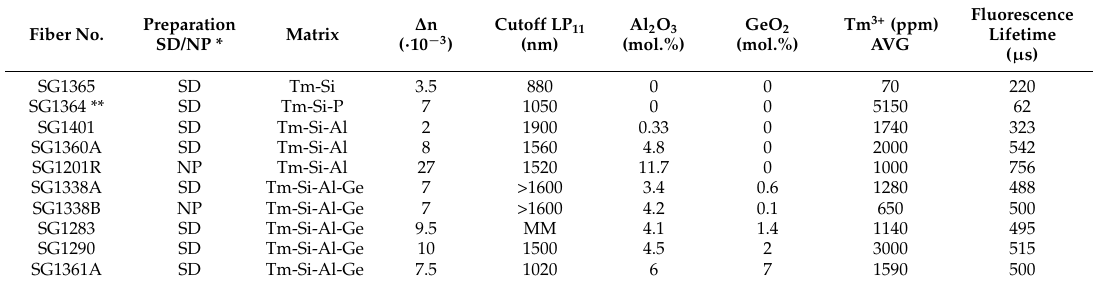
Table 1. Summary of the properties of the prepared preforms and optical fibers. Fiber No.